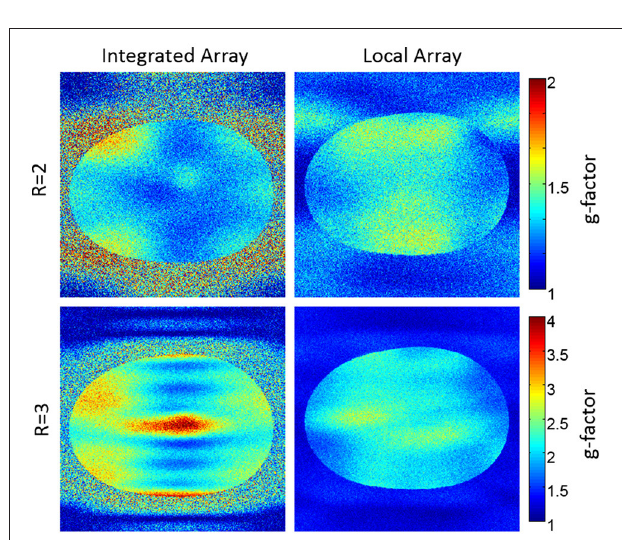
FIGURE 5 | GRAPPA g-factors for the two arrays for acceleration factors of R 2 and R 3. The phantom cross-section is not perfectly = =